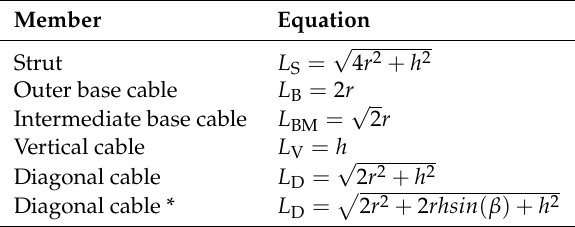
Figure 5. X-module column—designations. Table 4. X-module column—functions of the member lengths.